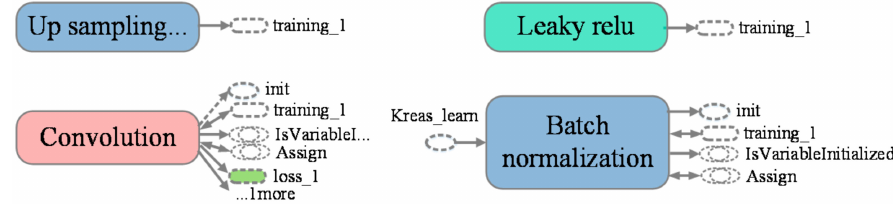
Figure 2. YOLO v3 visual format in TensorBoard.